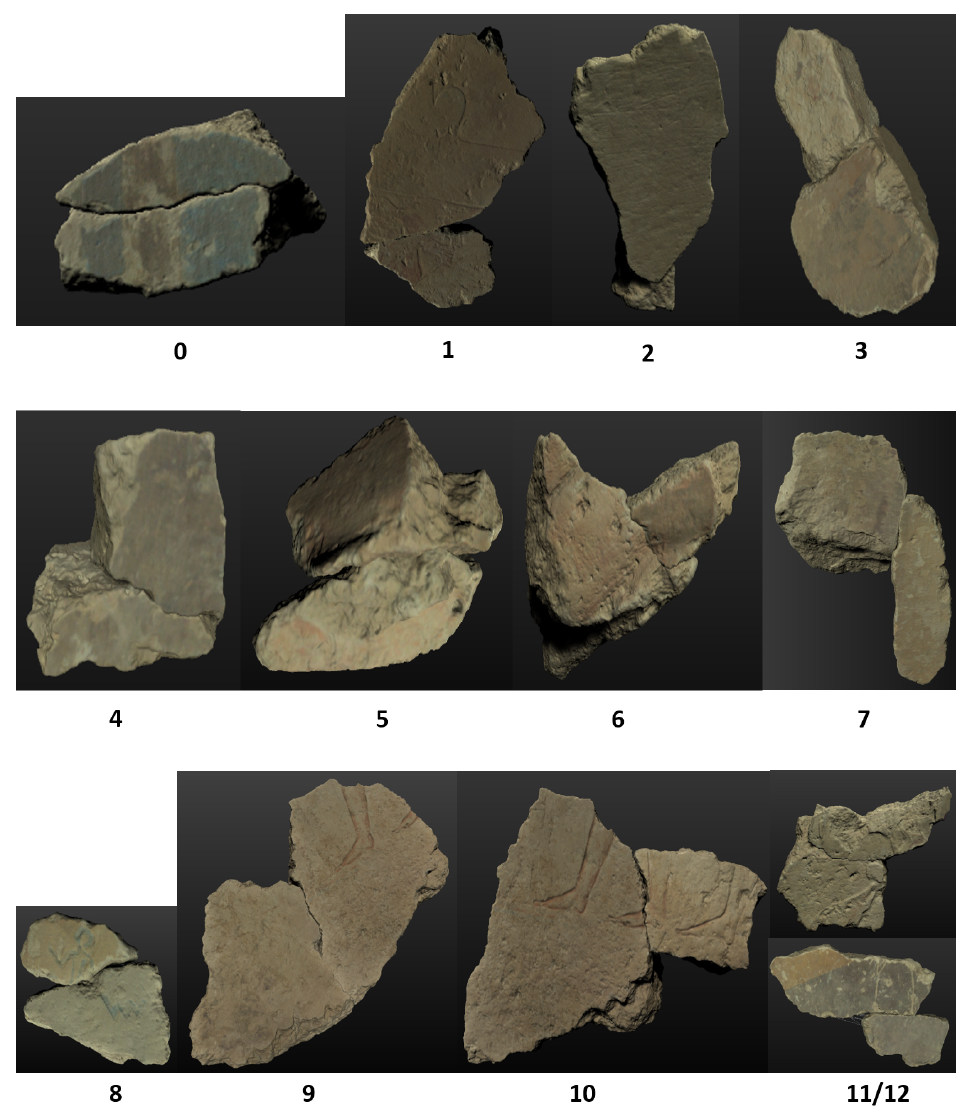
Figure 9. Brute force matching results: Pairwise solutions resulting from brute force matching approach. The matches were revised by experts who also refined the fragments’ alignment through the puzzling engine. The obtained rigid transformation are used as ground truth metrics to evaluate the proposed registration